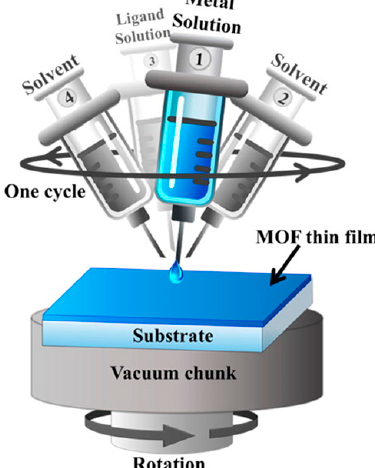
Figure 16. Representative examples of SEM micrographs of the top view ( left ) and cross-section ( right ) of the ZIF-8 membrane grown using 300 cycles of the LPE method on an alumina substrate (adapted with permission from ref. [52]).